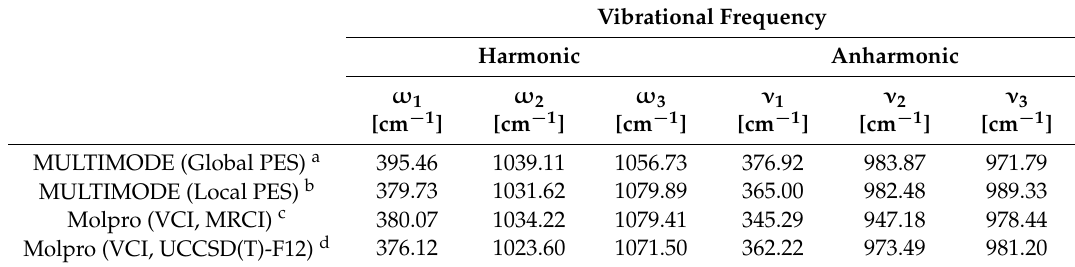
Table 3. Calculated harmonic ( ω i ) and anharmonic ( ν i ) vibrational frequencies of the ground electronic state of the Li 2 H complex using MULTIMODE on the local and global PESs and the VCI routine of MOLPRO at MRCI and UCCSD(T)-F12 levels ( ω 1 , ν 1 : bending; ω 2 , ν 2 : symmetric stretching; ω 3 , ν 3 : antisymmetric stretching).